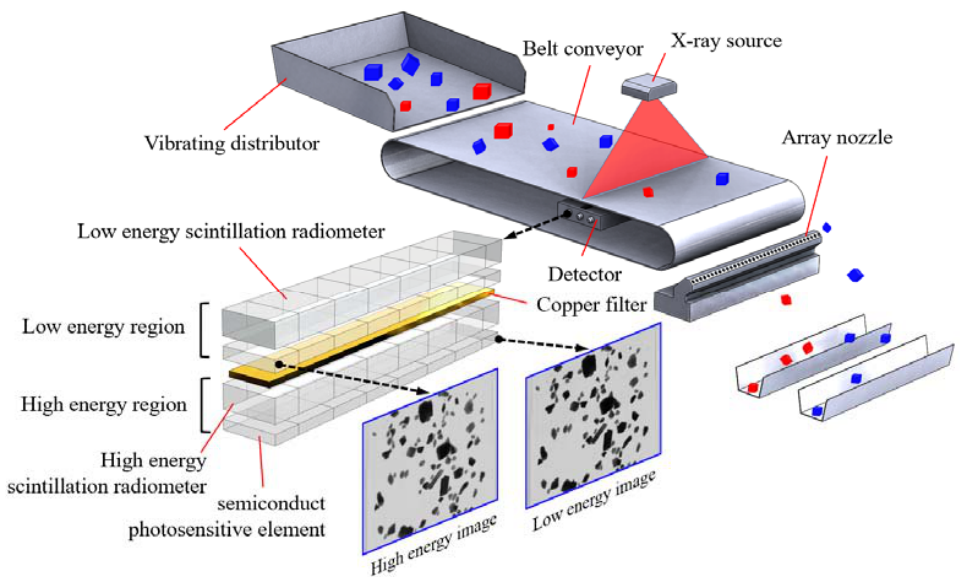
Figure 1. Principle of the dual ‐ energy X ‐ ray transmission (DE ‐ XRT) detection system.